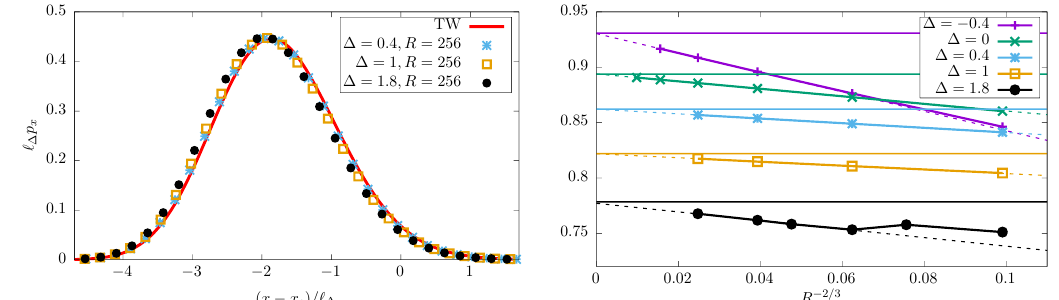
Figure 3: Left: rescaled dpdf for R = 256 and comparison with T-W (red line). Right: variance for a = 1 / 10 divided by the variance for a = 0, plotted as a function of R − 2 / 3 for several values of ∆ . The analytical prediction, given by ( 1 + 4 a ( 1 + ∆ )) − 1 / 3 is shown for comparison in thick horizontal lines. The data is extrapolated by a straight line, shown in dashed as a guide to the eye, with perfect agreement. The total chain length used for all simulations is L = 8 R .